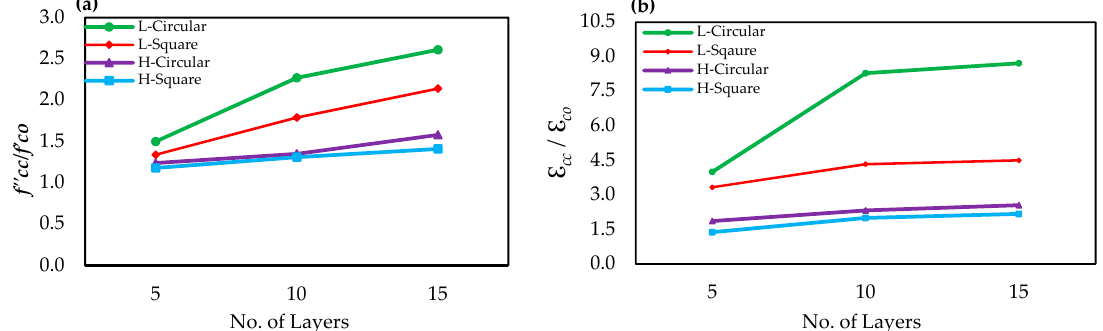
ff ect of JPFRP layers on ( a ) strength enhancement and ( b ) strain Figure 11. Effect of JPFRP layers on ( a ) strength enhancement and ( b ) strain enhancement. Figure 11. E